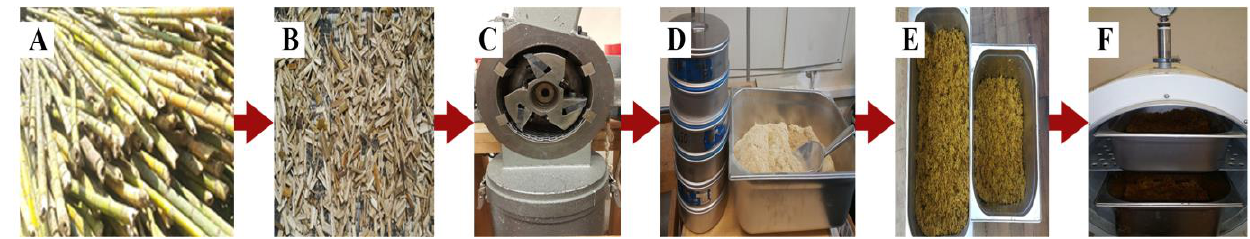
Figure 2. BP preparation steps: ( A ) harvesting; ( B ) chopping and sun dying; ( C ) grinding; ( D ) sieving to targeted particle size; ( E ) surface treatment; ( F ) vacuum oven drying.